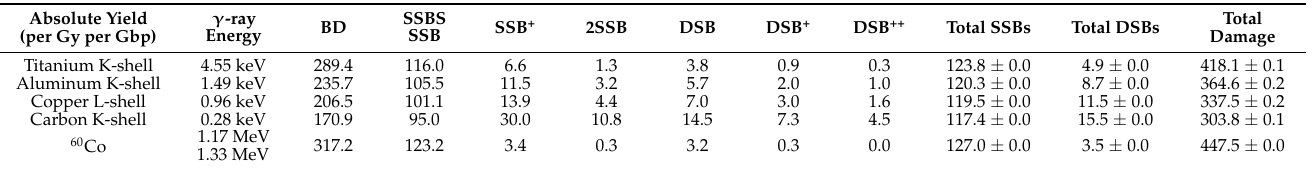
Table 4. Absolute yields of DNA damage (per Gy per Gbp) induced by ultrasoft X-rays and 60 Co γ -rays under severe hypoxia